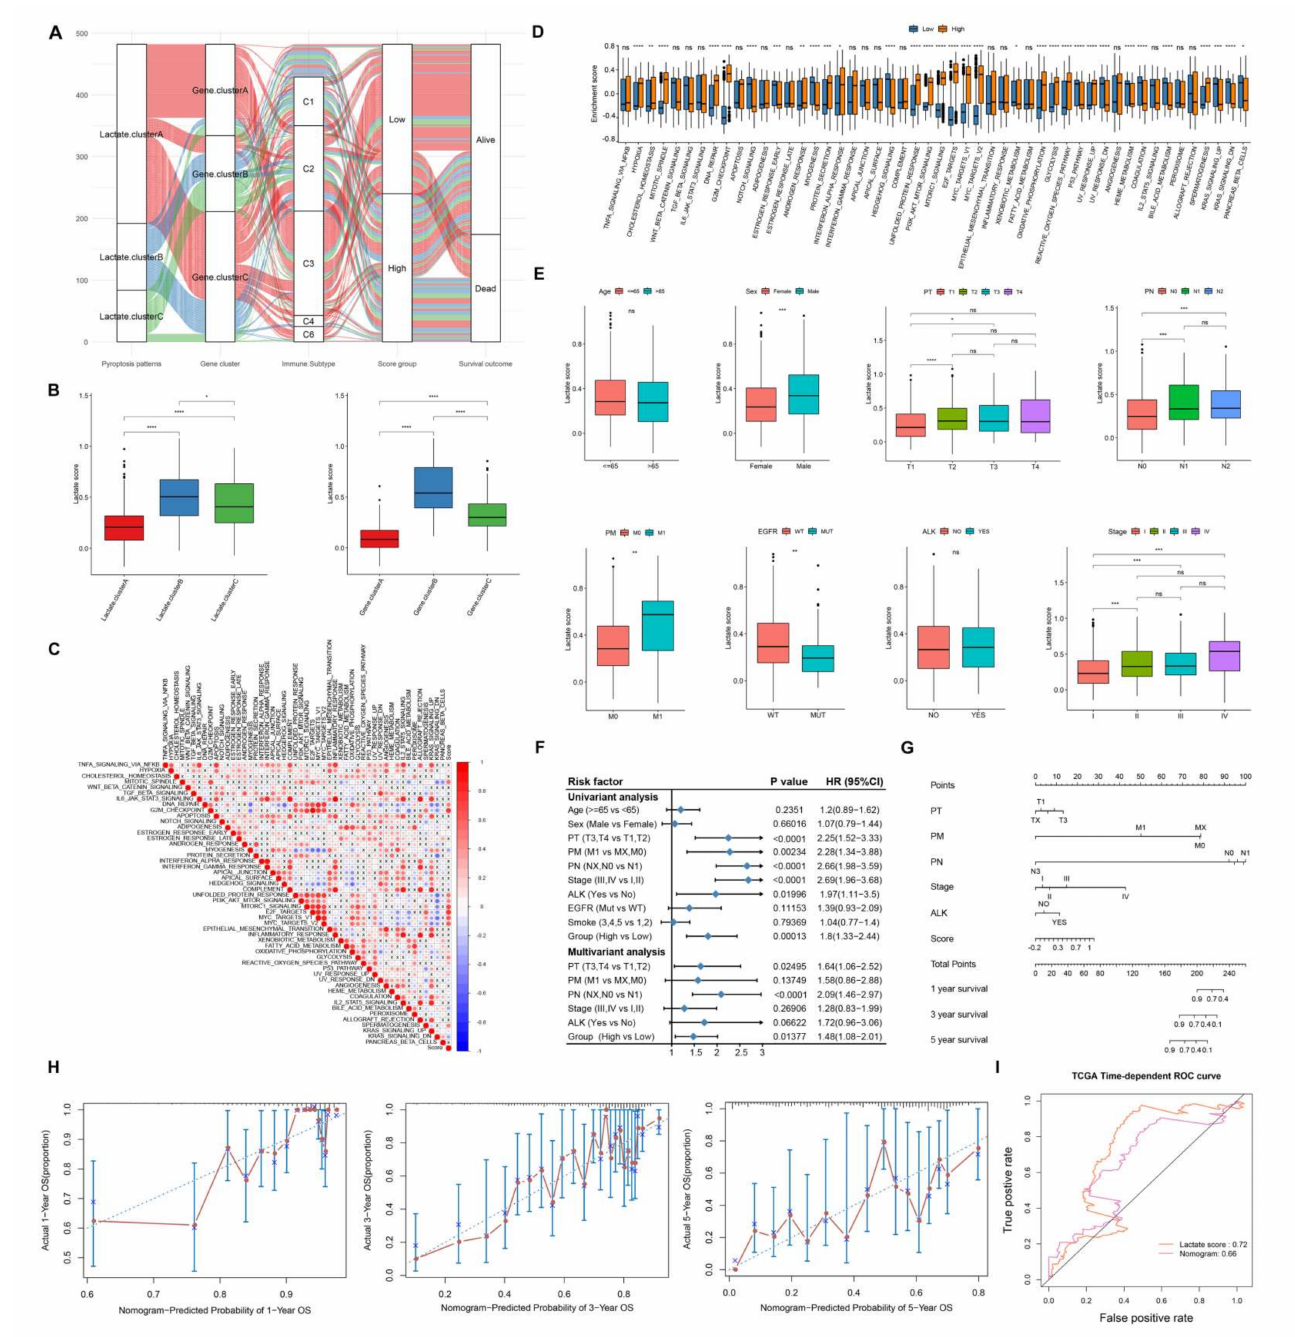
Figure 5. Characteristics of lactate-related score risk model. ( A ) Alluvial diagram showing the correspondence among the lactate cluster, gene cluster, immune subtype, score group, and survival outcome. C1: wound healing, C2: interferon γ dominant C3: inflammatory, C4: lymphocyte-depleted, and C5: transforming growth factor β dominant. ( B ) Risk scores of different lactate gene expression patterns (initial) ( left ) and differentially expressed gene patterns ( right ). ( C ) Correlation between the risk score and the Hallmark Pathway. ( D ) Hallmark pathway differences between high and low risk groups. ( E ) Risk score distribution of samples with different clinical characteristics (age, sex, stage, PT, PM, PN, EGFR mutation, and ALK rearrangement). ( F ) Univariate cox analysis of the clinical characteristics and multivariate cox analysis of six prognosis-related factors. ( G ) The column chart of six factors and their score and prognosis. ( H ) Forecasting curves of nomogram-predicted probability and actual 1, 3, and 5 year OS. ( I ): ROC curve of nomogram and lactate